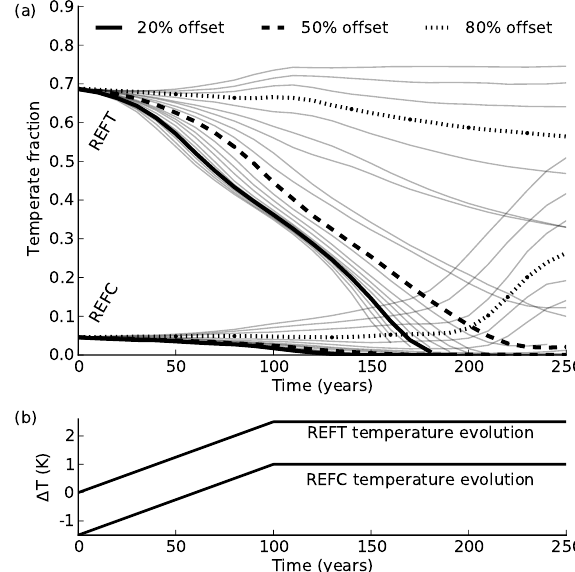
Fig. 8. Temporal evolution of the fraction of temperate ice with changing environmental conditions for time-dependent models. Each line in (a) represents a scenario with a different net accumulation response to a single function for temperature (b). Near-surface aquifer thickness h aq decreases and equilibrium line altitude z ELA rises when net balance is lowered (all scenarios). Models in which winter accumulation offsets 20%, 50%, and 80% of the increased summer melt are shown by the solid, dashed, and dotted bold lines, respectively. For reasons described in the text, the lines are terminated when glacier length falls below 3km.